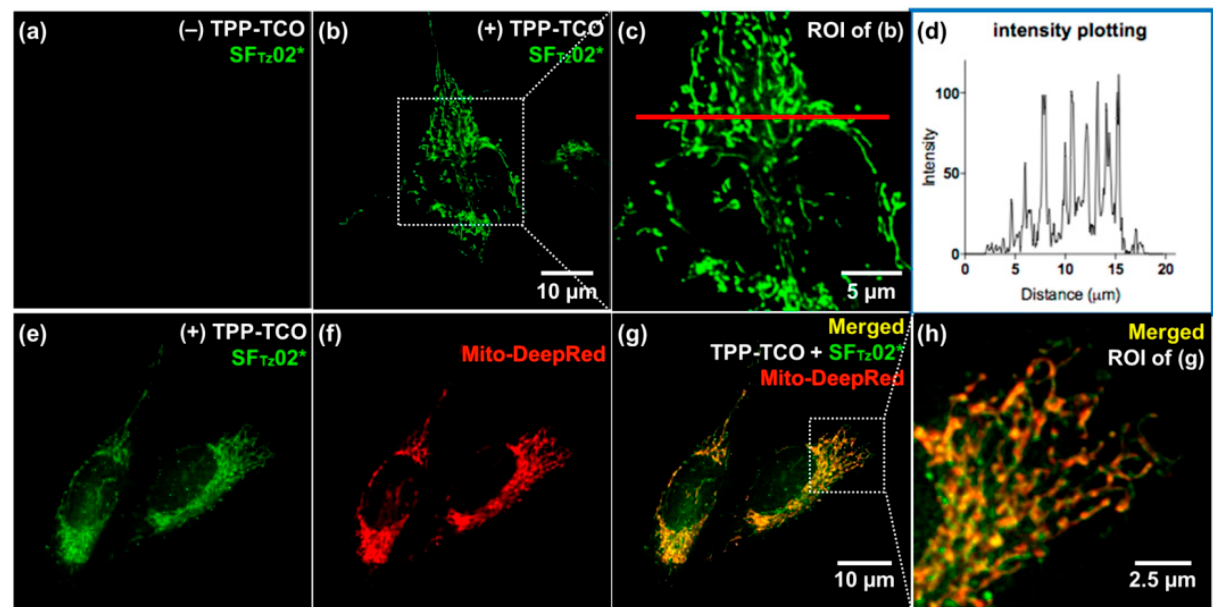
Figure 7. No-wash fluorogenic imaging of mitochondria with SF Tz probes. HeLa cells were treated with dimethylsulfoxide ( a ) or triphenylphosphonium (TPP) − TCO (10 µM; b , c , e , g , and h ) with MitoTracker Deep Red ( f − h ). After brief washing with phosphate buffered saline, SF Tz 02* ( a , b , c , e , g , and h ) was used to treat the cells, and the images were immediately observed without washing. ( d ) Plot intensity values of pixels along the red line in ( c ) were analyzed with the ImageJ program. ROI = region of interest. Reproduced with permission from [29]. Copyright (2018) American Chemical Society.